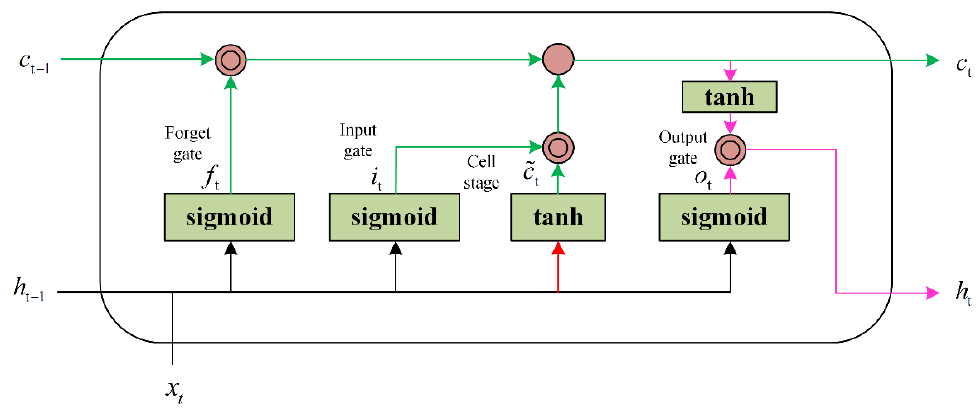
Figure 2. Schematic diagram of the LSTM cell structure. There are four types of gating units in LSTM cells: Forget gate, Input gate, Cell stage and Output gate. c t and c t − 1 are the state of the cell at time t and time t − 1. h t and h t − 1 are the state of the hide at time t and time t − 1. x t is the input variable at time t.